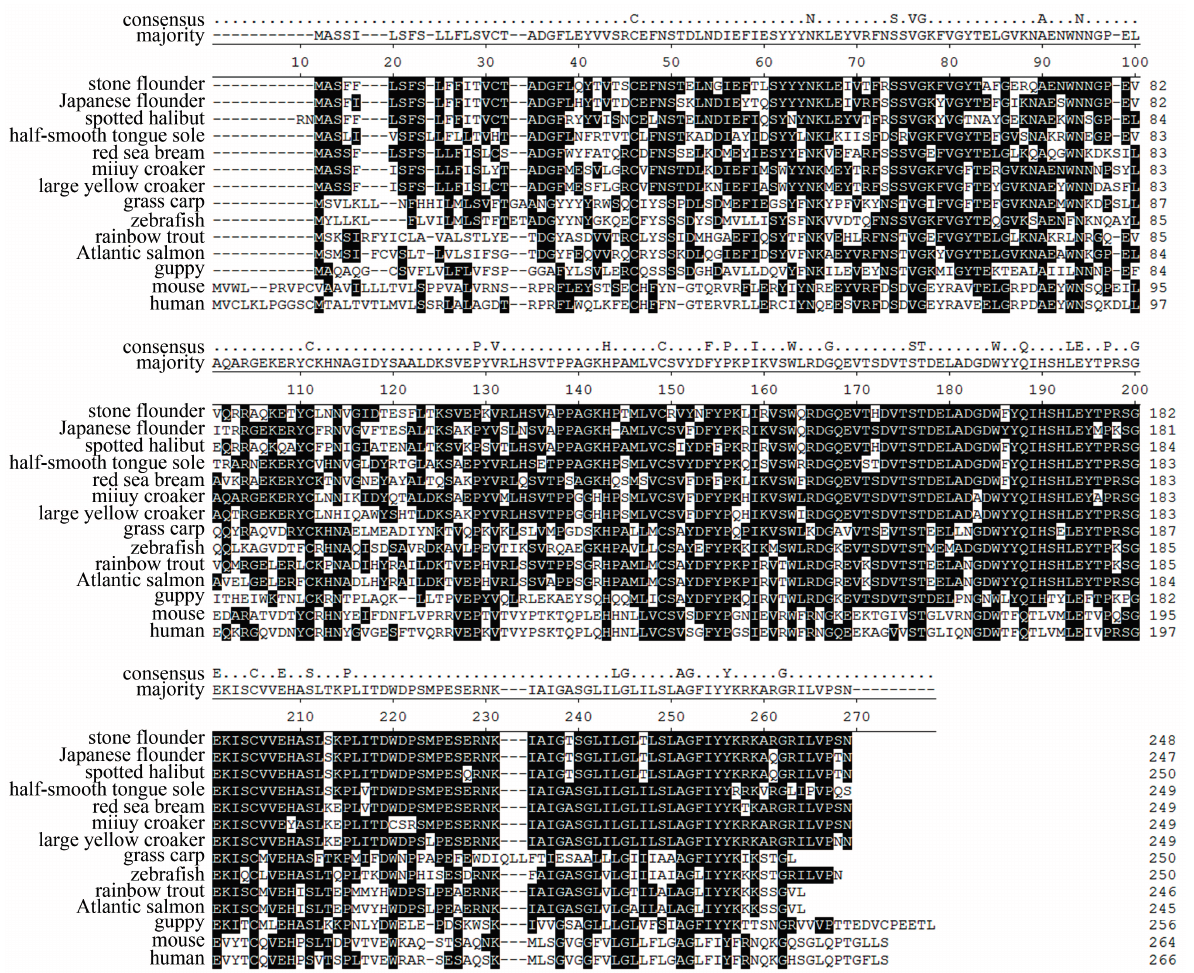
Figure 6. Alignment of peptides encoded by MHC class II B in fourteen species. Gaps are indicated by dashes. Conserved sites are marked black. The consensus sites are indicated on top. The Genbank numbers of these sequences are: AFY98547 (stone flounder), AII02001 (Japanese flounder), ADB43564 (spotted halibut), AAP20186 (red sea bream), ABV48909 (large yellow croaker), ADV36785 (miiuy croaker), AEM75094 (grass carp), CAD87794 (zebrafish), AAD53026 (rainbow trout), CAA49726 (Atlantic salmon), AAC34836 (guppy), P18469 (mouse), and AAA59781